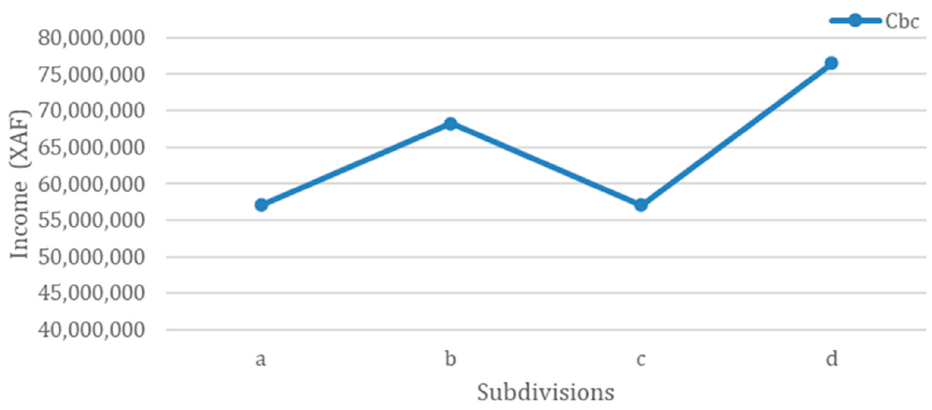
Figure 9. Change in incomes based on farm subdivisions in Figure 8.